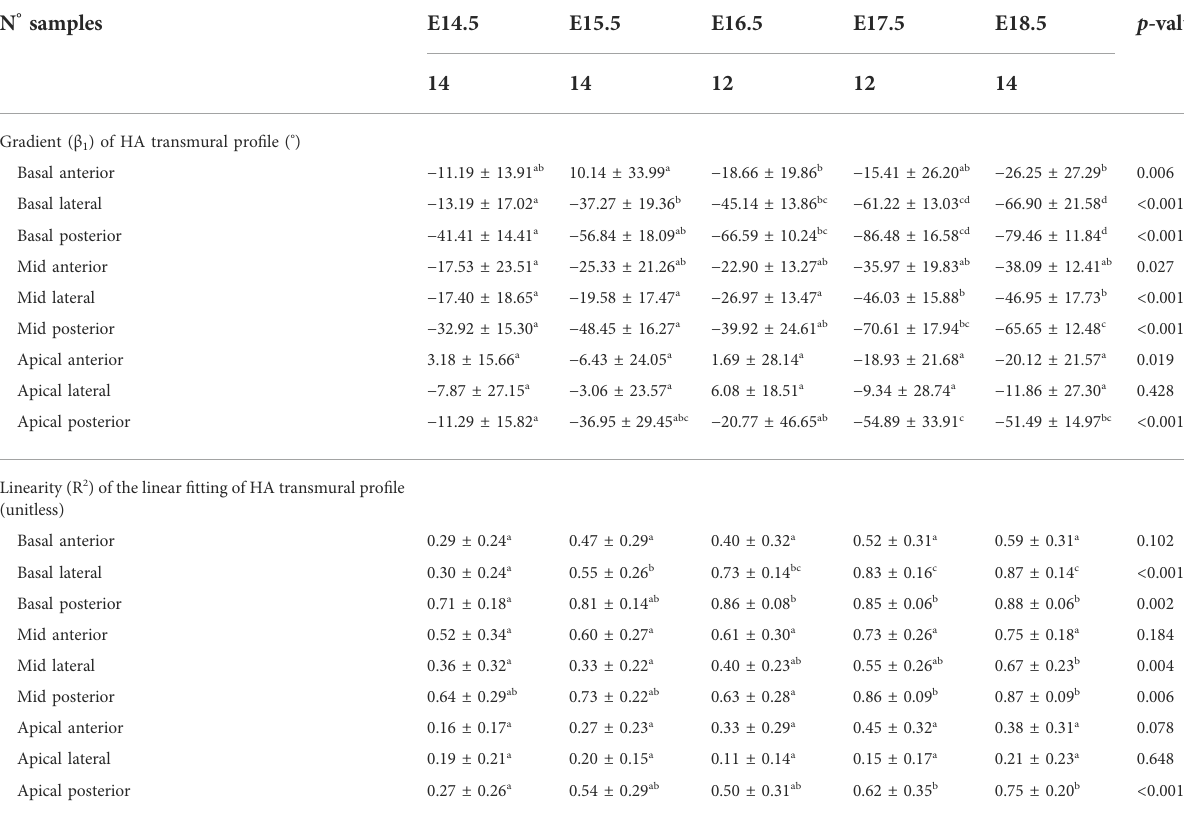
TABLE 3 Parameters of the linear fi tting: y = β 1 · x + β 0 , of helical angle (HA) transmural pro fi le within the right ventricle (RV), expressed as mean ± standard deviation. N °